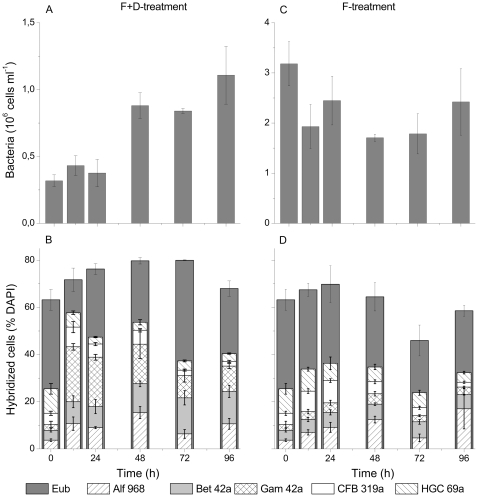
Development of bacterial communities in the experiments.Numbers of bacteria (A & C); and composition of bacterial community (B & D) in the F+D- (5 µm prefiltration and 1∶10 dilution) and F- (5 µm prefiltration) treatments. Error bars show standard deviation, based on the triplicate samples. Eub – bacteria targeted by the general probe Eub I-II-III, Alf968 – Alphaproteobacteria (probe Alf 968), Bet42a – Betaproteobacteria (probe Bet42a), Gam42a – Gammaproteobacteria (probe Gam42a), CFB319a – Cytophaga–Flavobacteria (probe CFB319a), HGC69a – Actinobacteria (probe HGC69a). Note that the Y-axis scale differs between the panels.